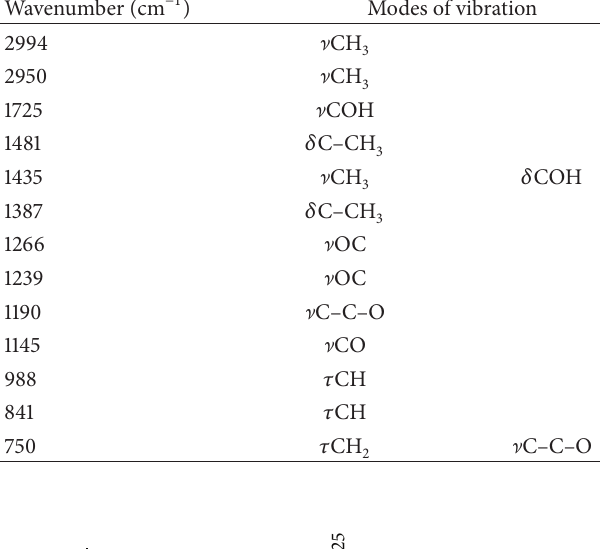
Table 3: Observed vibrational modes for PMMA. Wavenumber (cm −1 )